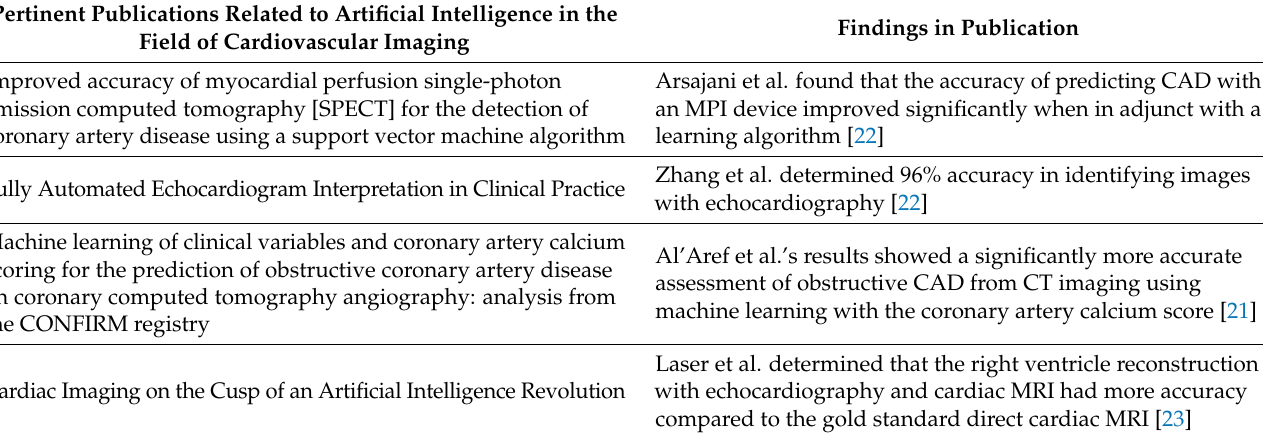
Table 2. Pertinent publications regarding artificial